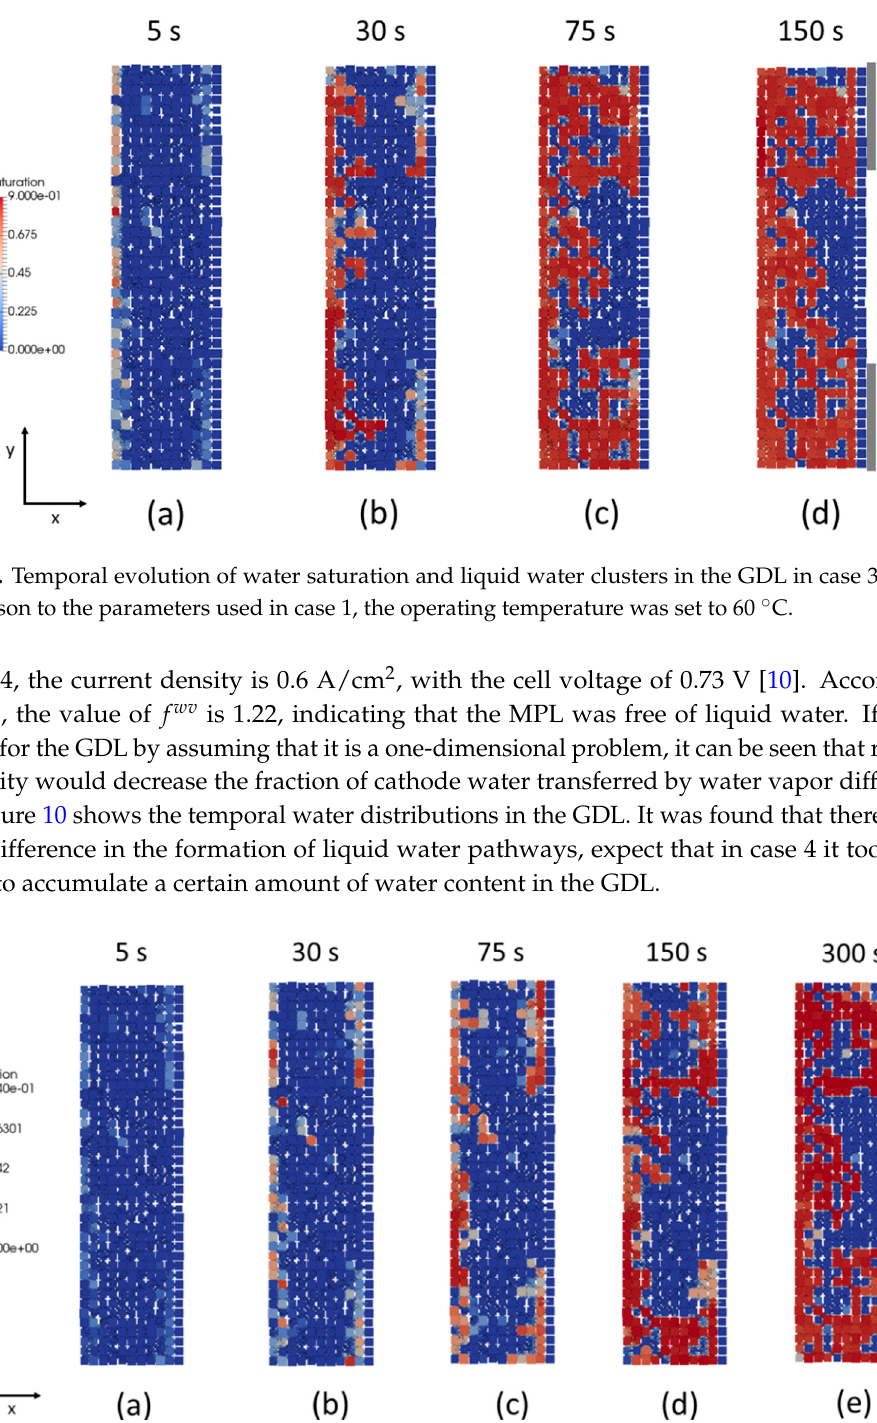
Figure 10. Temporal evolution of water saturation and liquid water clusters in the GDL in case 4. In comparison to the parameters used in case 1, the current density was set to 0.6 A/cm 2 .